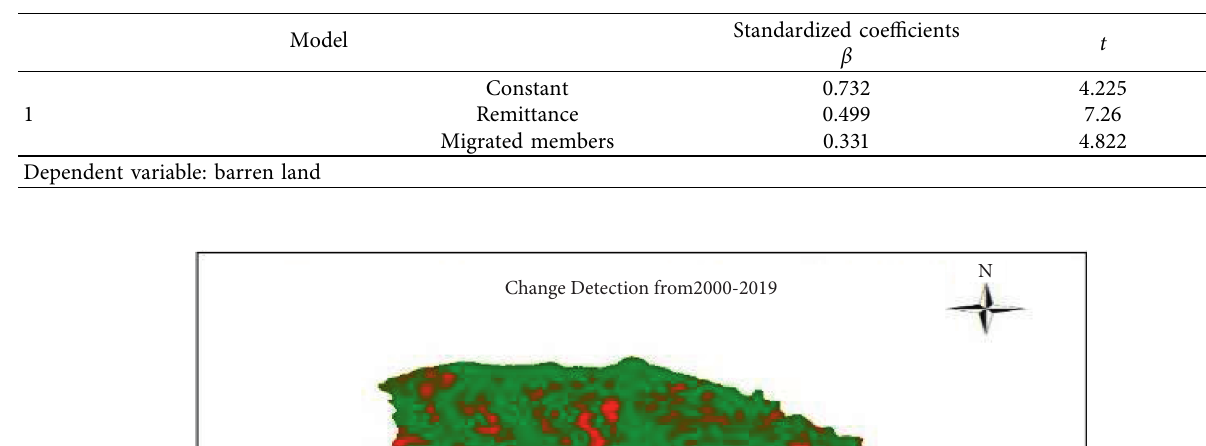
Table 5: Coefficient of the model.